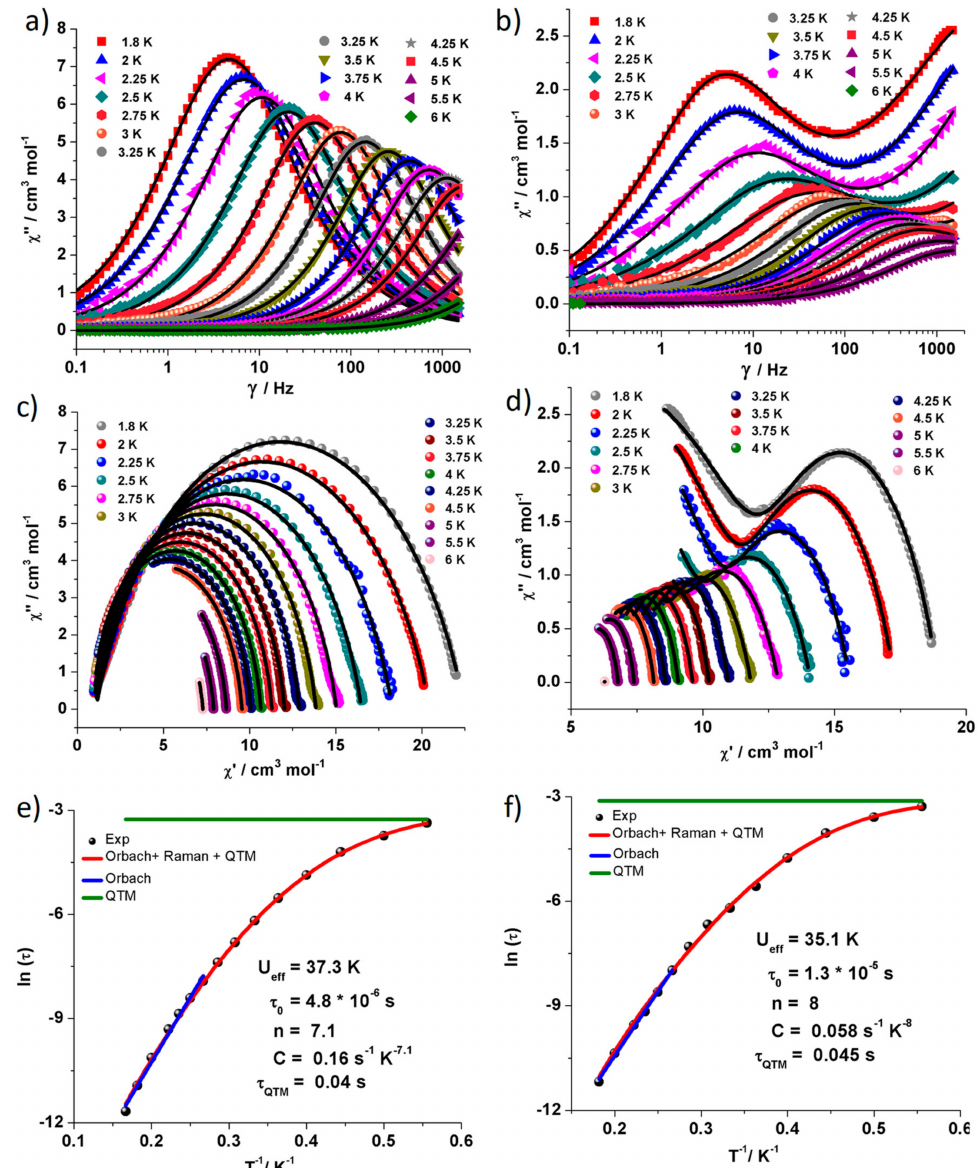
Figure 4. χ M ” vs. Frequency plot for ( a ) 1 and ( b ) 3 , H dc = 1000 Oe and Cole − Cole plots between 1.8 − 6 K for ( c ) 1 and ( d ) 3 . The solid black lines are fitted values obtained from CC-fit program [20]. Magnetization relaxation time ( τ ), plotted as ln( τ ) versus T − 1 for ( e ) 1 and ( f ) 3 . The solid blue line corresponds to fitting of the Orbach relaxation process and the solid red line represents the best fitting to the multiple relaxation process. The horizontal green line represents the QTM relaxation